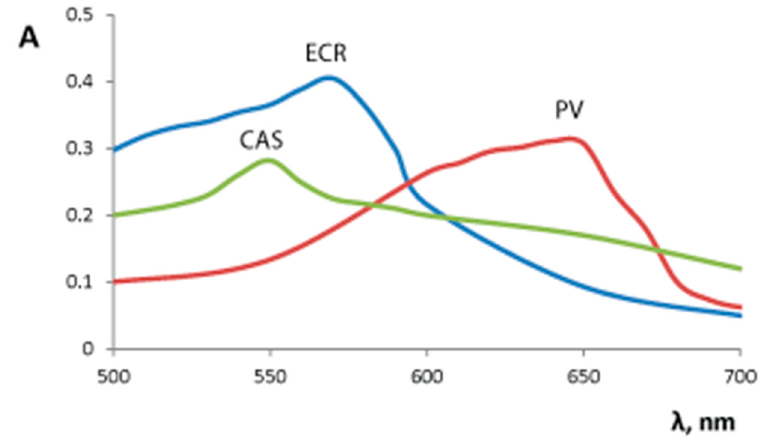
Figure 1. Absorption spectra of silica–titania xerogels after the interaction with 1 × 10 − 4 M triphenylmethane dyes solution. PV—pyrocatechol violet (pH 7.3), ECR—eriochrome cyanine R (pH 2.0), CAS—chrome azurol S (pH 3.0). m/V = 0.10 g/5.0 mL, time of contact is 20 min.